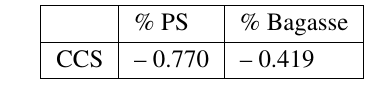
Table 8. Correlation table for CCS of bagasse based